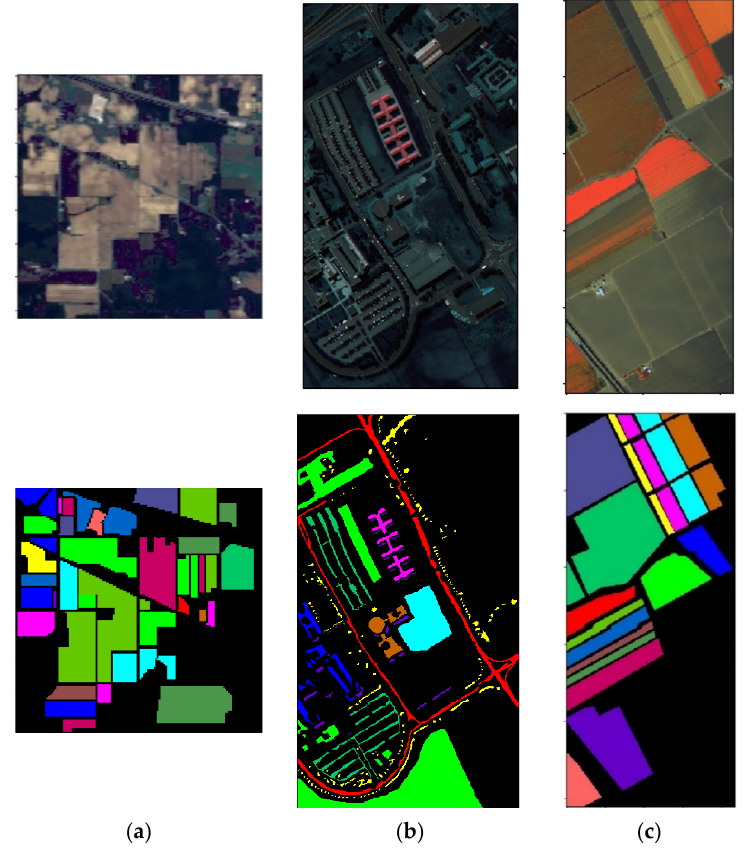
Figure 2. False-color composites (first row) and ground truths (second row) of experimental HSI datasets. Each color represents one kind of object. ( a ) Indian Pines; ( b ) PaviaU; ( c ) Salinas. Real samples were divided into a training set and a test set by random sampling. A